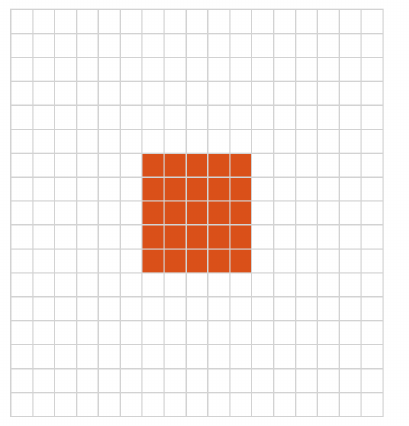
Figure 1. Two-dimensional grid-like study region with randomly generated count data. The red subregions in the center constitute a